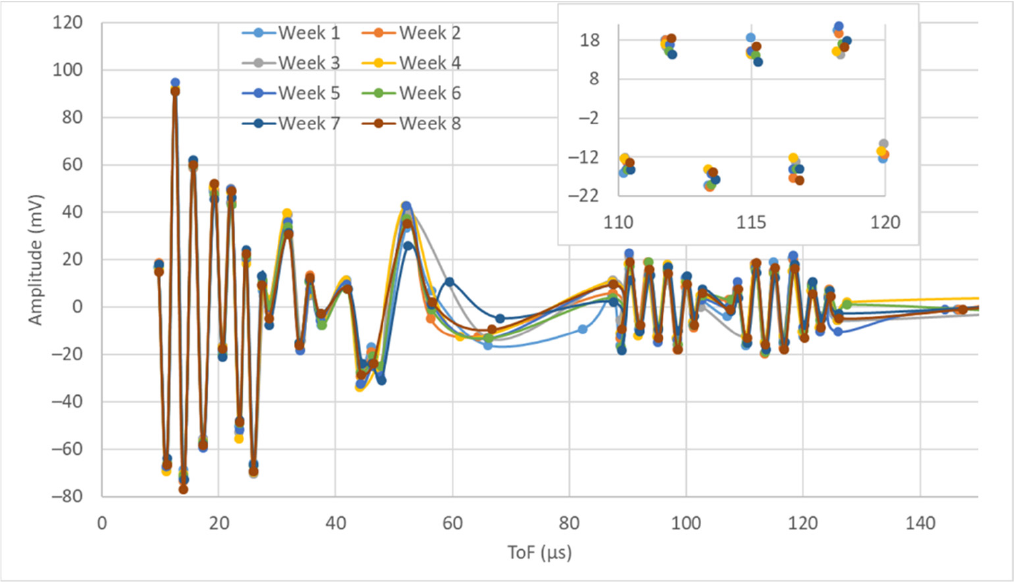
Figure 7. E1R4 signal acquired during the eight Mondays of the testing campaign. General view with CPs and interpolation lines and a detailed view with CPs.